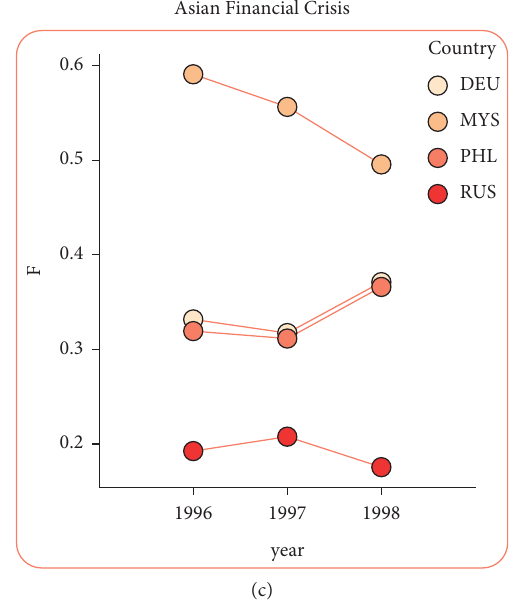
Figure 5: Resilience scores in BOP crisis.